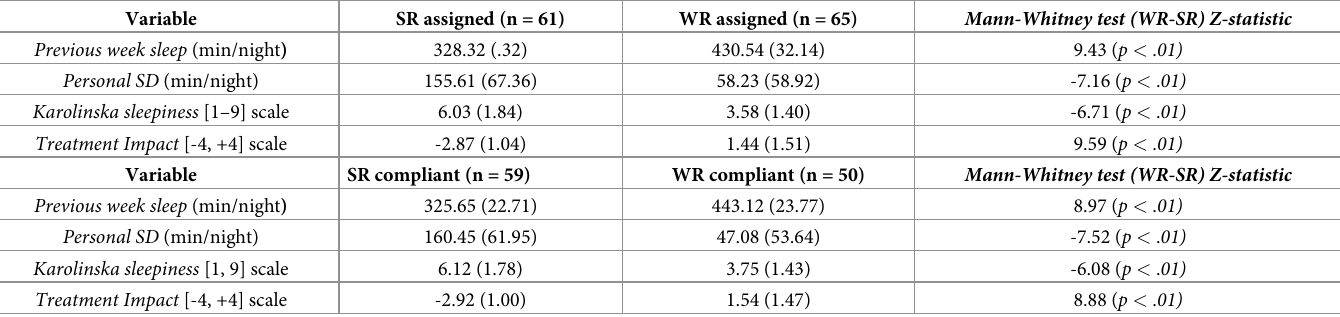
Table 2. Compliance with sleep protocol (objective and subjective measures) means (st dev) in